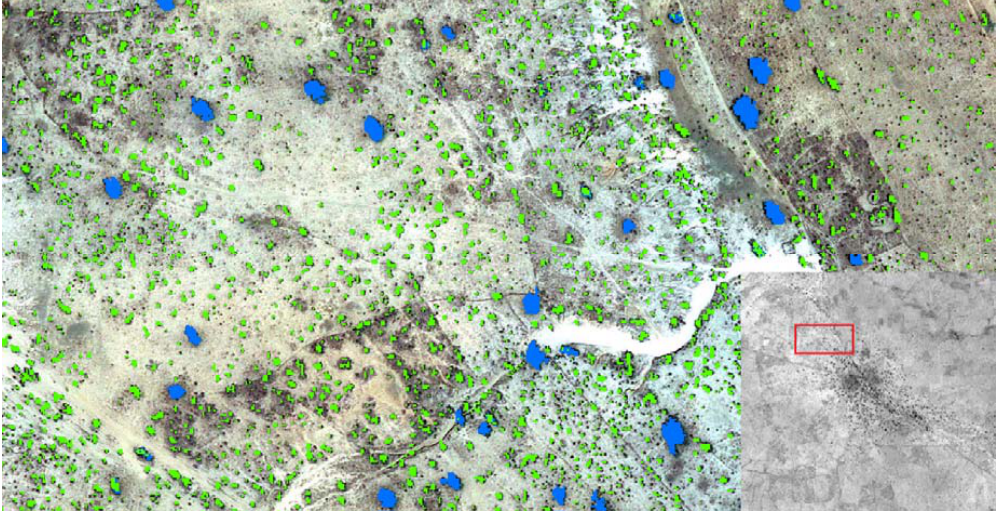
Figure 11. Classification in 3 classes superposed to the original Digital Globe Image. Guileyni, 2011.